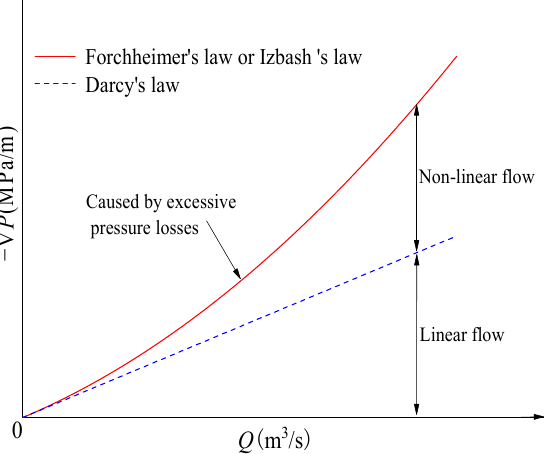
Figure 1. Increase of − ∇ P greater than that of Q in linear proportion (traditional conclusion).